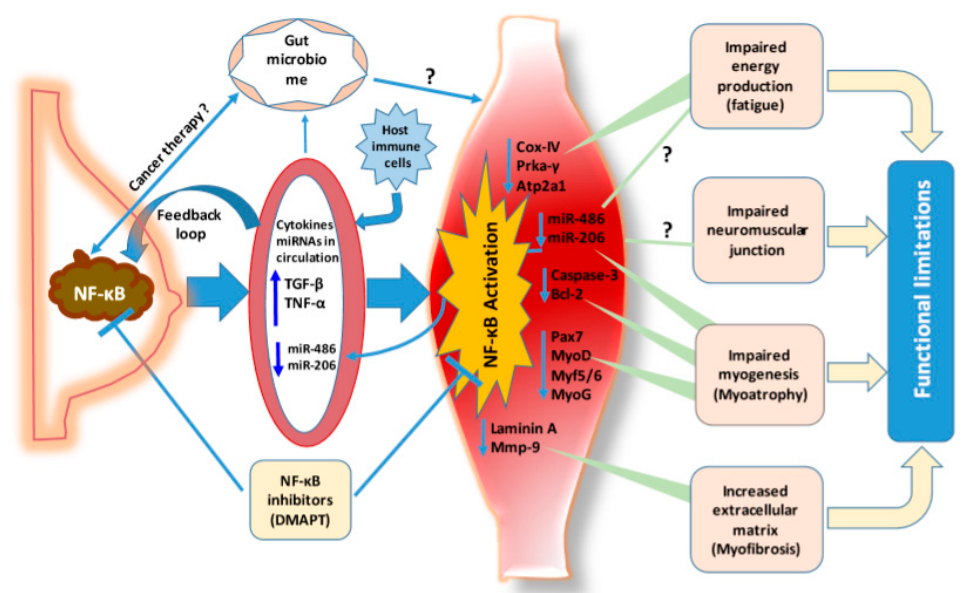
Figure 1. Systemic actions of breast cancer on skeletal muscles lead to functional limitations. Tumors in the breast release growth factors and cytokines into the circulating system. In response to tumors, host immune cells in breast tissue and other organs also release growth factors and cytokines into